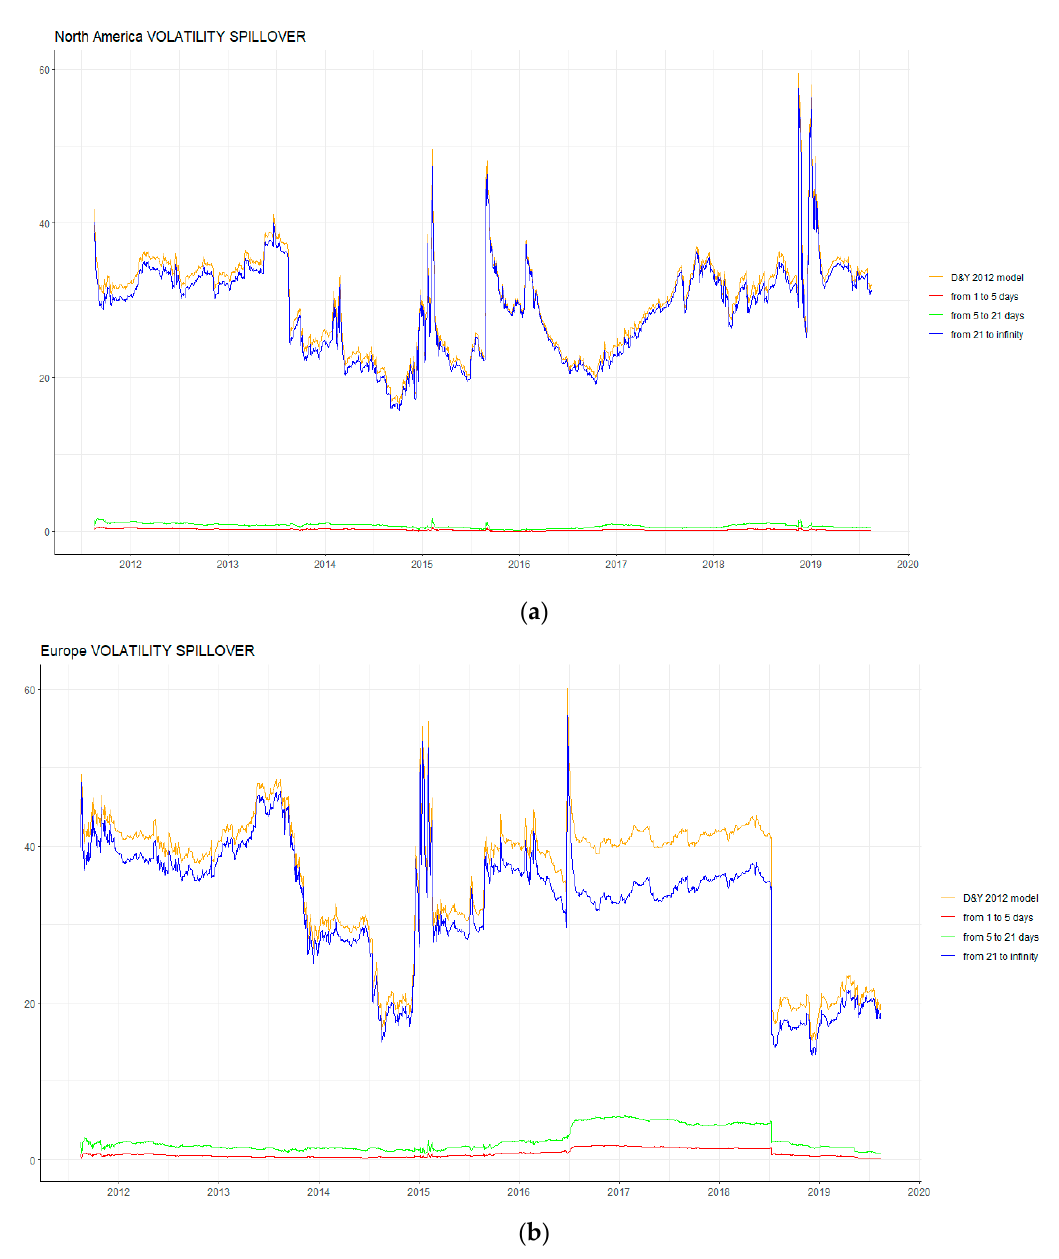
Figure 5. ( a ) The total volatility spillover of DY12 and BK18 in North America (Windows 500). ( b ) The total volatility spillover of DY12 and BK18 in Europe (Windows 500). Note: The yellow line indicates the total spillover index of the DY12 model; the red line indicates the total spillover index at “Freq S” of the BK18 model; the green line indicates the total spillover index at “Freq M” of the BK18 model; the blue line indicates the total spillover index at “Freq L” of the BK18 model. The vertical axis variable unit is in percentages.